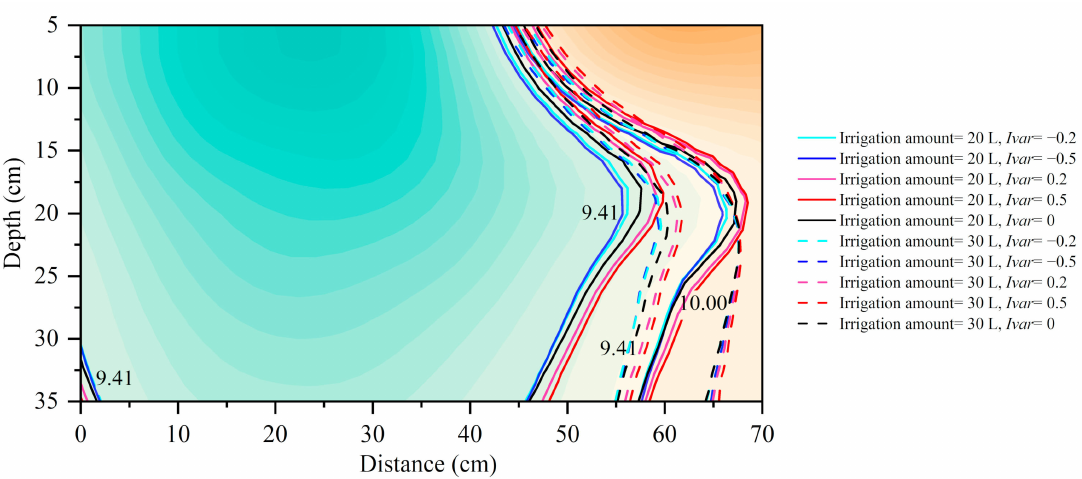
Figure 14. The 2D distribution of soil salinity at the end of scenario under different total irrigation amounts, and Ivar , for